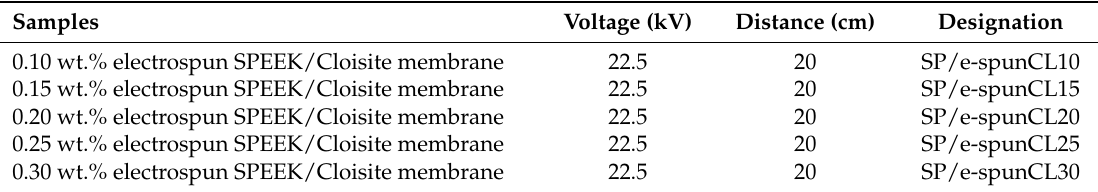
Figure 1. ( a – c ) The preparation steps in producing void free dense SP/e-spunCL membranes [1]. Table 1. The designation of membrane